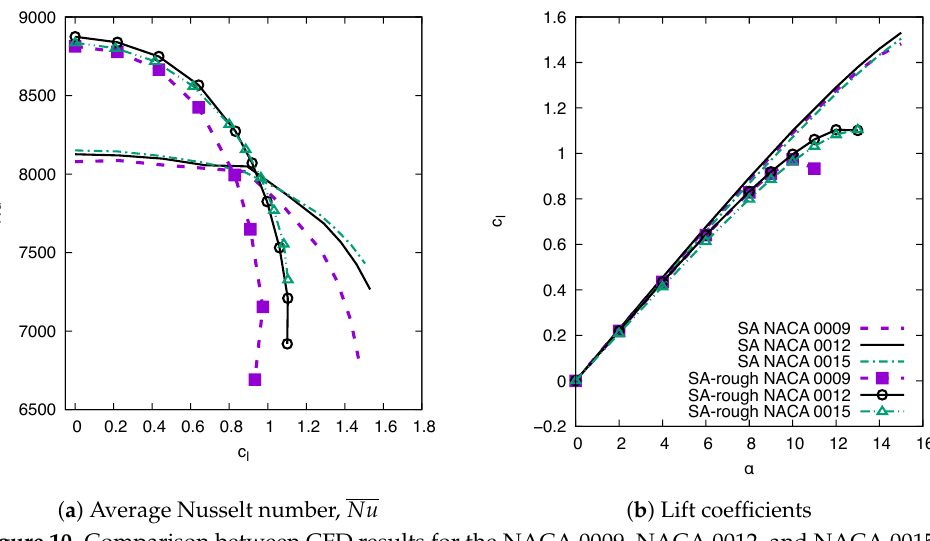
Figure 10. Comparison between CFD results for the NACA 0009, NACA 0012, and NACA 0015 at Re = 6 × 10 6 , smooth and rough leading